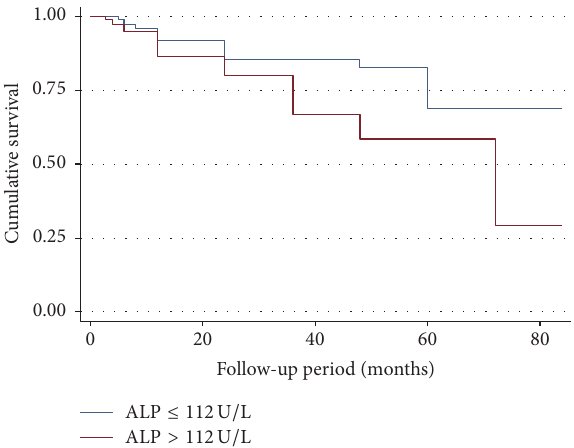
Figure 3: Kaplan Meier survival curves for different categories of calcium ( 𝑃 = 0.02 ). Calcium categories based on KDOQI reference